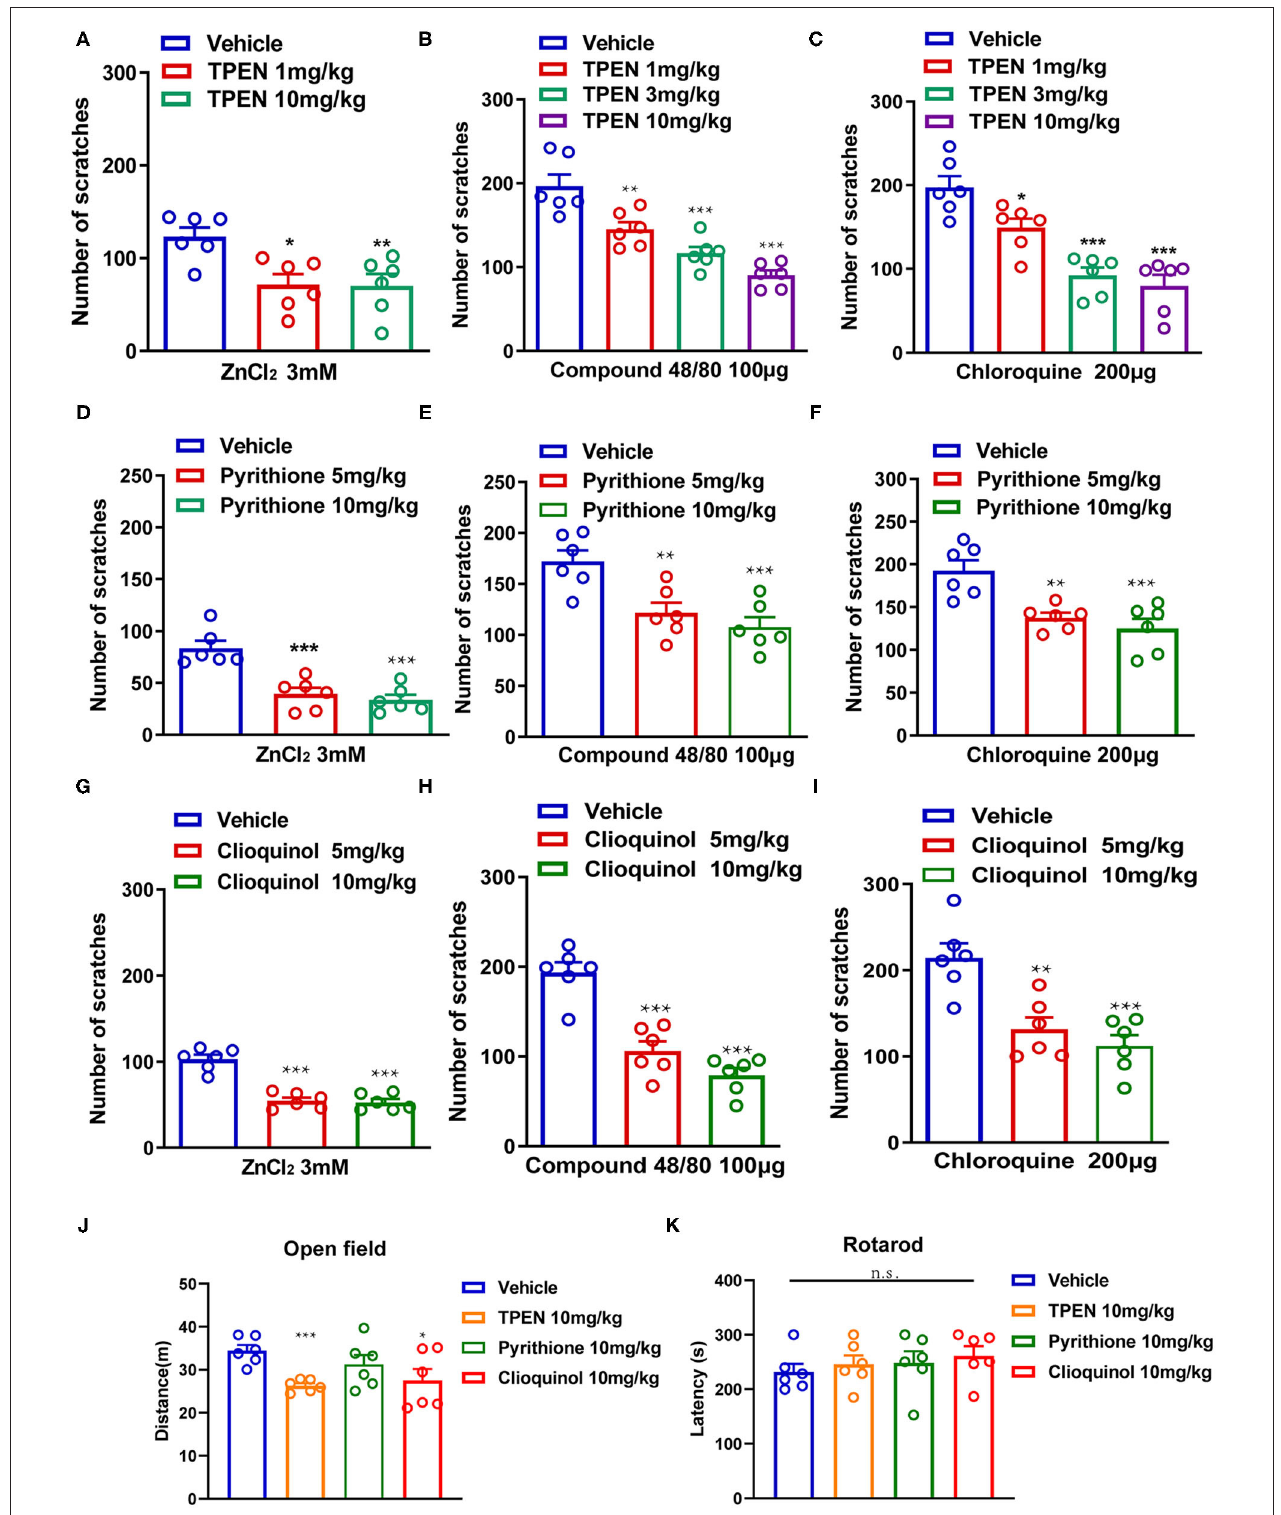
FIGURE 5 | Zinc chelators attenuated acute itching behavior in mice. (A–C) The effects of intraperitoneal (i.p.) injection of TPEN (1–10 mg/kg) on ZnCl 2 [ (A) ; 3mM], compound 48/80 [ (B) ; 100 µ g], and chloroquine-induced itch [ (C) ; 200 µ g] in mice. (D–F) The effects of pyrithione (5–10 mg/kg; i.p.) on ZnCl 2 [ (D) ; 3mM], compound 48/80 [ (E) ; 100 µ g], and chloroquine-induced itch [ (F) ; 200 µ g] in mice. (G–I) The effects of clioquinol (5–10 mg/kg; i.p.) on ZnCl 2 [ (G) ; 3mM], compound